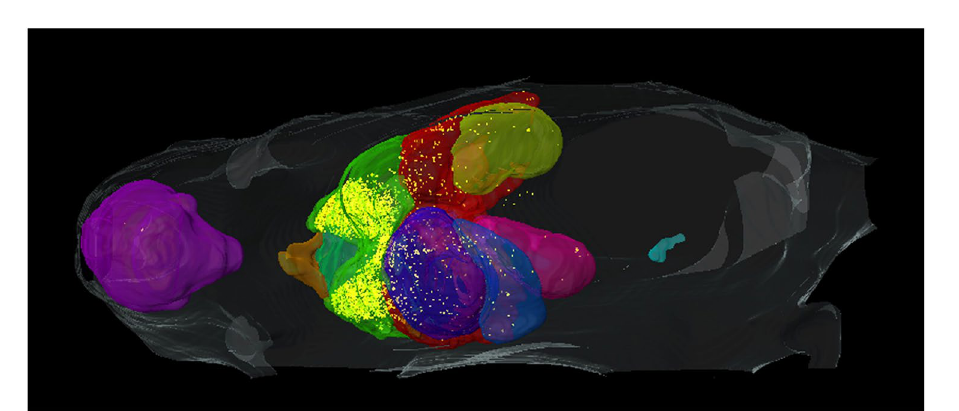
Figure 9. Examples showing analysts’ edits of various organs. Predicted segmentations are outlined with solid lines. Edits are shown as transparent shaded regions. Analysts added regions to the stomach, heart, liver, and bladder (white arrows) and removed regions in the liver (black arrow).